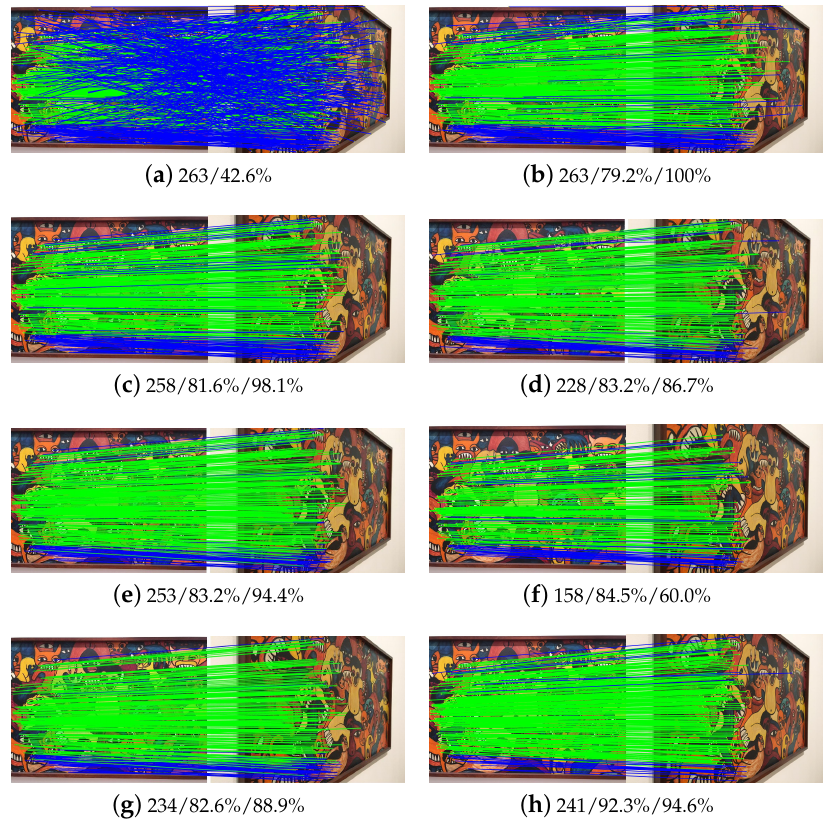
Figure 14. Matching results of image pair 6 in the rigid dataset: ( a ) initial matches; ( b ) RANSAC; ( c ) K-VLD; ( d ) WGTM; ( e ) LLT; ( f ) GMS; ( g ) LAM; ( h )